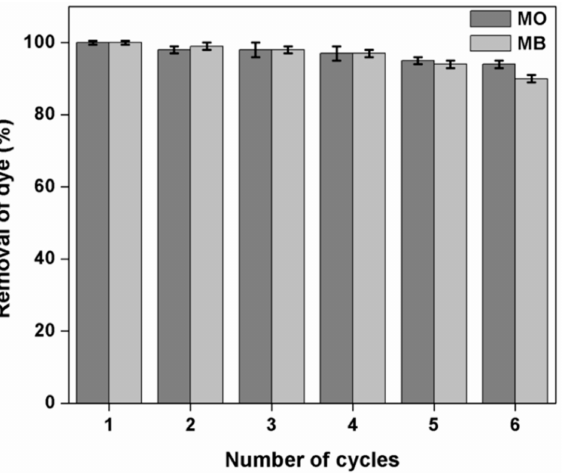
Figure 13. Reusability efficiency of the Kg-Ch sponge for the adsorption of MO and MB dyes (adsorbent dose = 20 Mg; temperature = 30 ◦ C and initial dye concentration = 20 Mg L − 1